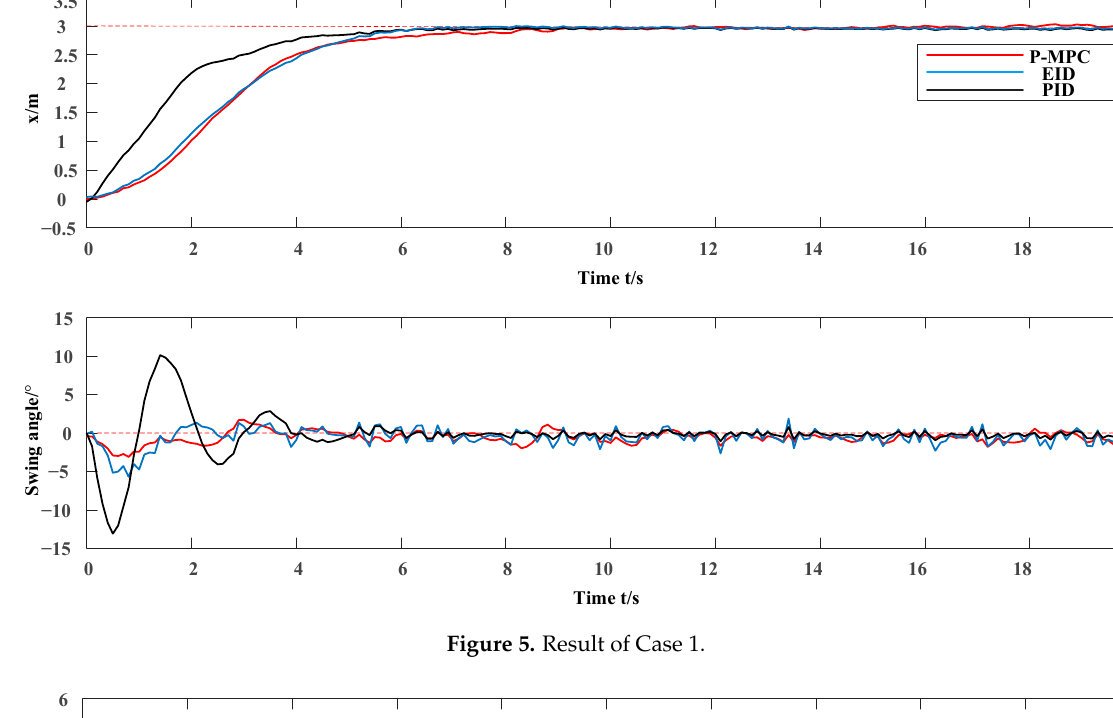
Figure 5. Result of Case 1.